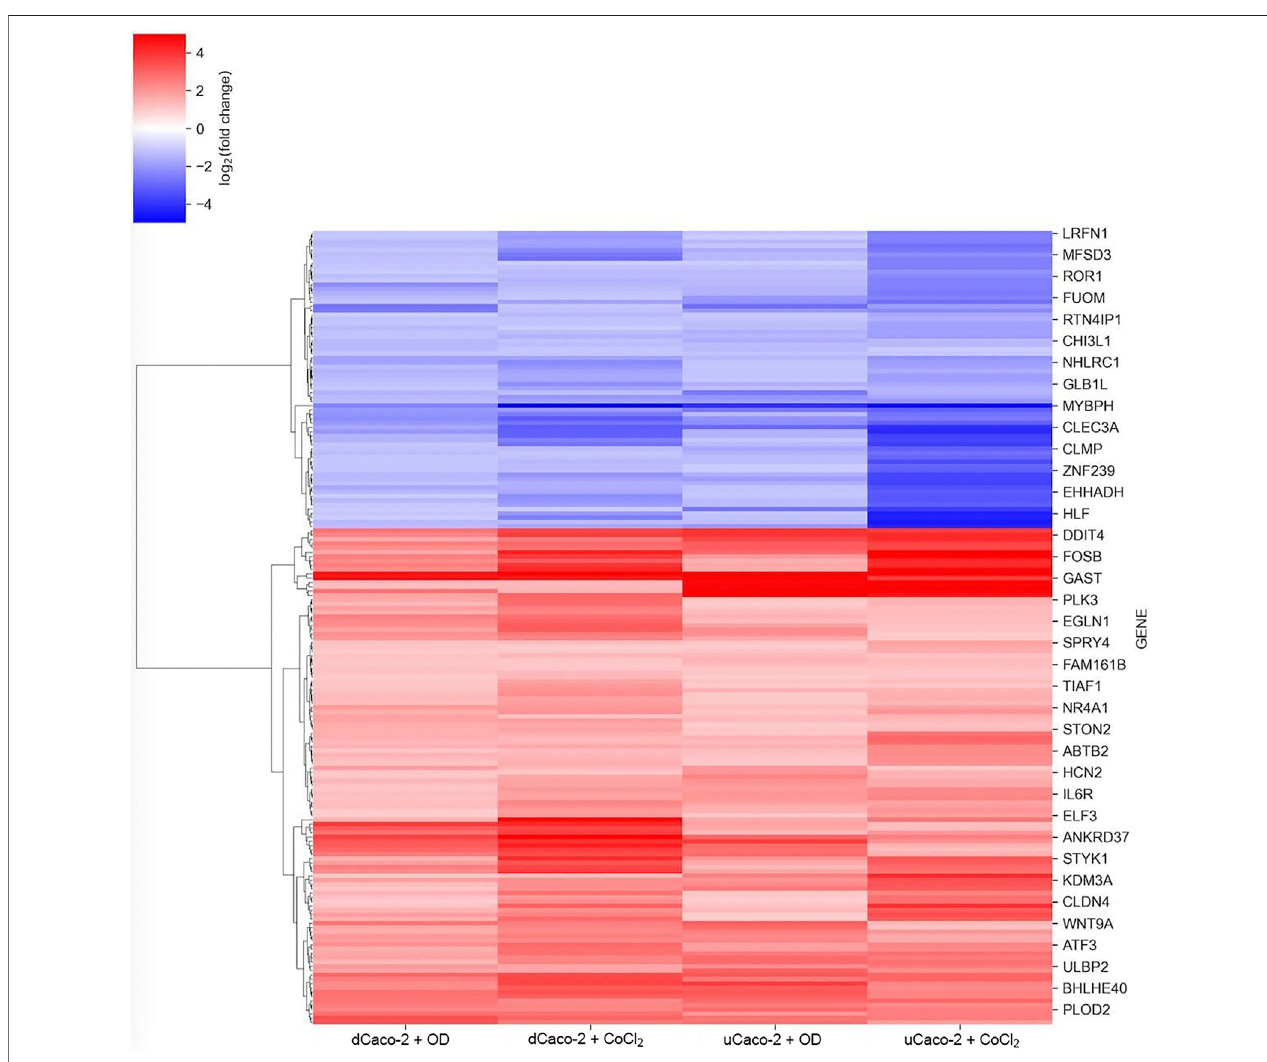
FIGURE3| mRNAexpressionchangesforthecoregenesetreactingtochemicalhypoxiasimulationindifferentiatedCaco-2(dCaco-2)andundifferentiatedCaco- 2 (uCaco-2) upon cobalt (II) chloride (CoCl2) and oxyquinoline derivative (OD) treatment.